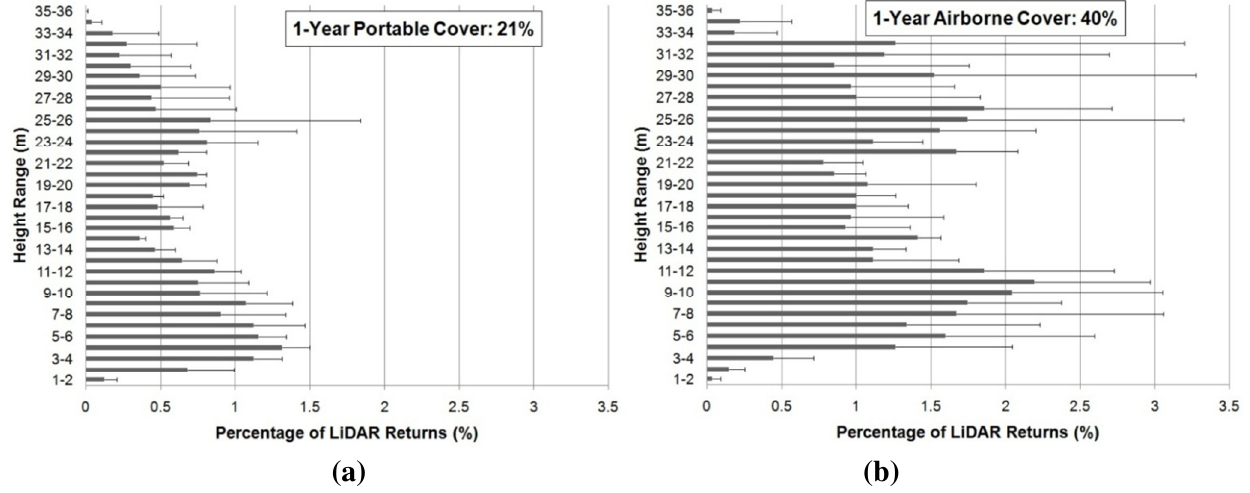
Figure 4. Vertical Distribution of Portable (a) and Airborne (b) LiDAR returns for the 1-Yr Fire Return Interval Treatment Stoddard Plots (TTRS, FL). Error bars correspond to the standard deviation of the three plot replicates per treatment.